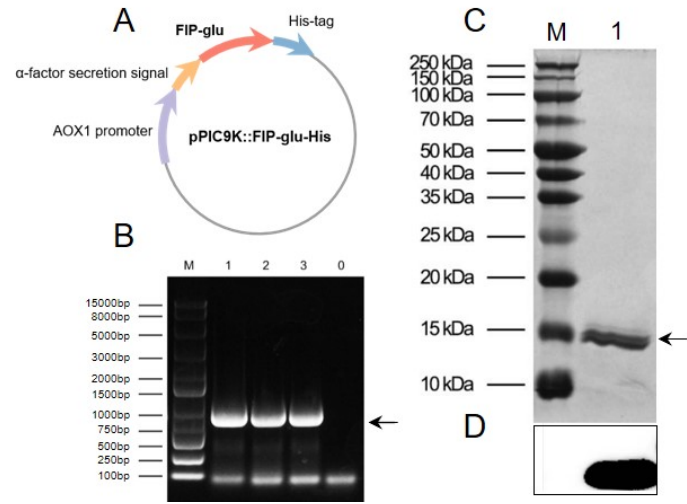
Figure 1. Preparation of rFIP-glu in Pichia pastoris . ( A ) Construction of the recombinant plasmid pPIC9K::FIP-glu-His. ( B ) Identification of yeast transformants by PCR analysis. Lane M, DNA Ladder; Lane 1–3, rFIP-glu yeast transformant DNA; Lane 0, negative control. ( C ) SDS-PAGE analysis. Lane M, molecular weight marker; Lane 1, rFIP-glu. ( D ) Western blot analysis.